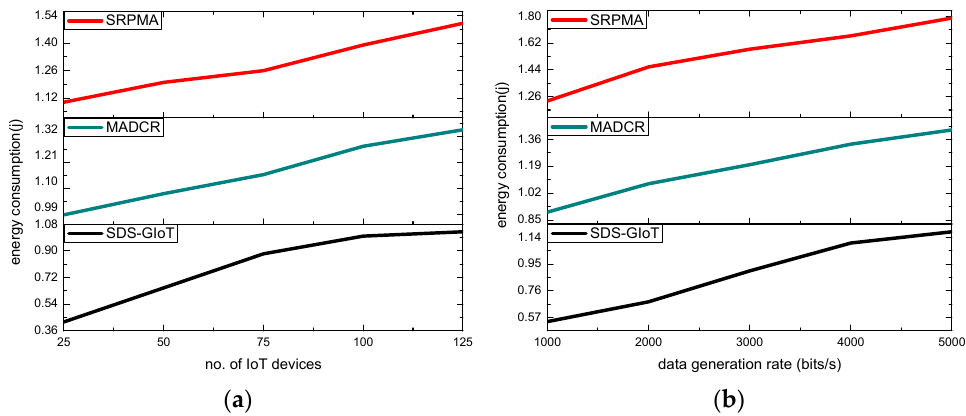
Figure 8. Scenarios for varying IoT devices and data generation rates in terms of energy consump- tion. ( a ) energy consumption and IoT devices. ( b ) energy consumption and data generation rates.